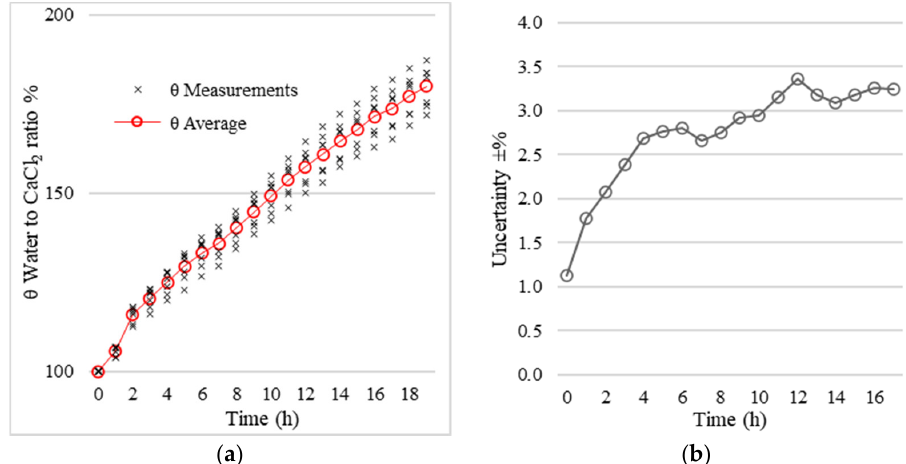
Figure 2. ( a ) Average of water-to-salt mass ratio measurements. ( b ) Uncertainty of water-to-salt mass ratio measurements.